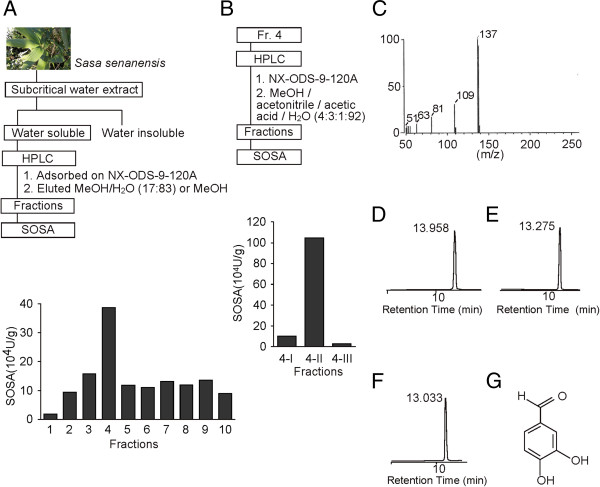
Purification and identification of PA. (A) Purification of antioxidative compounds from S. senanensis leaves. Subcritical water extracts were prepared from the leaves and fractionated by HPLC with MeOH/H2O (17:83). The SOSA was assessed for each fraction, and the highest value detected in fraction 4. (B) Purification of the compound by HPLC. Fraction 4 was further fractionated, and fraction 4-II found to contain the highest SOSA. (C) EI-MS spectra data of purified PA, which was identified using the SDBS. (D–F) HPLC chromatograms of fraction 4-II (D), synthetic PA (E), and a mixture of fraction 4-II and synthetic PA (F), in which the two compounds were co-eluted as a single peak. (G) Chemical structure of PA.